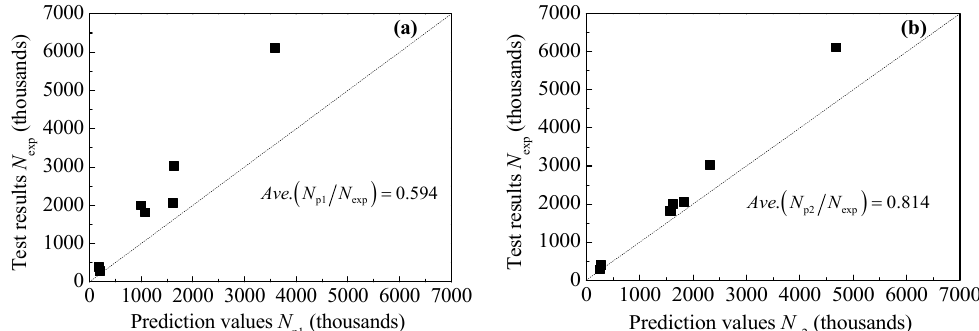
N versus N ( b ) N p1 exp p2